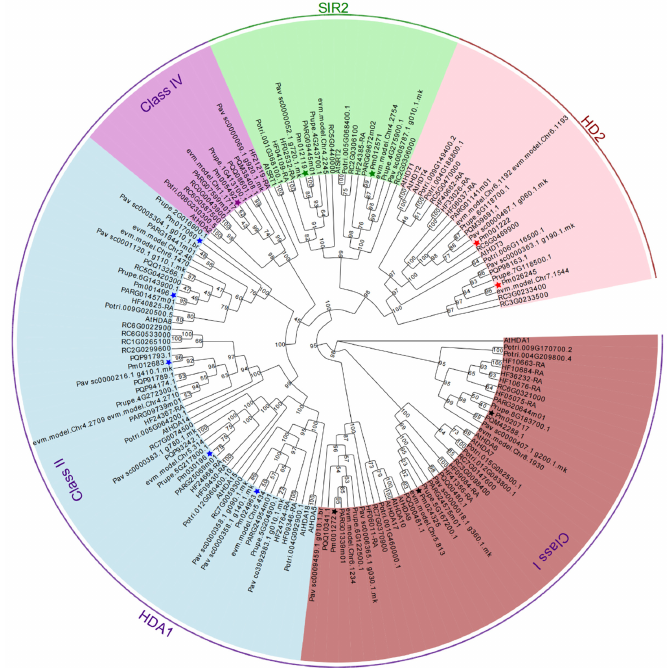
Figure 1. Maximum likelihood phylogenetic tree of histone deacetylases HDACs family in 10 plants. The phylogenetic tree in A. thaliana (At), P. trichocarpa (Potri), and Rosaceae plants including P. mume (Pm, 13), P. salicina (evm), P. armeniaca (PAR), P. persica (Pruep), P. avium (Pav), P. yedoensis (PQM), M. domenstica (HF) and R. chinensis (RC) was reconstructed using IQtree 2.1.3. Bootstrap support of each node was inferred from 1000 replicates. Members marked with asterisks represent mei PmHDACs . The red, bule and purple clusters are classified into HDA1 superfamily named as Class I, II and IV, respectively.